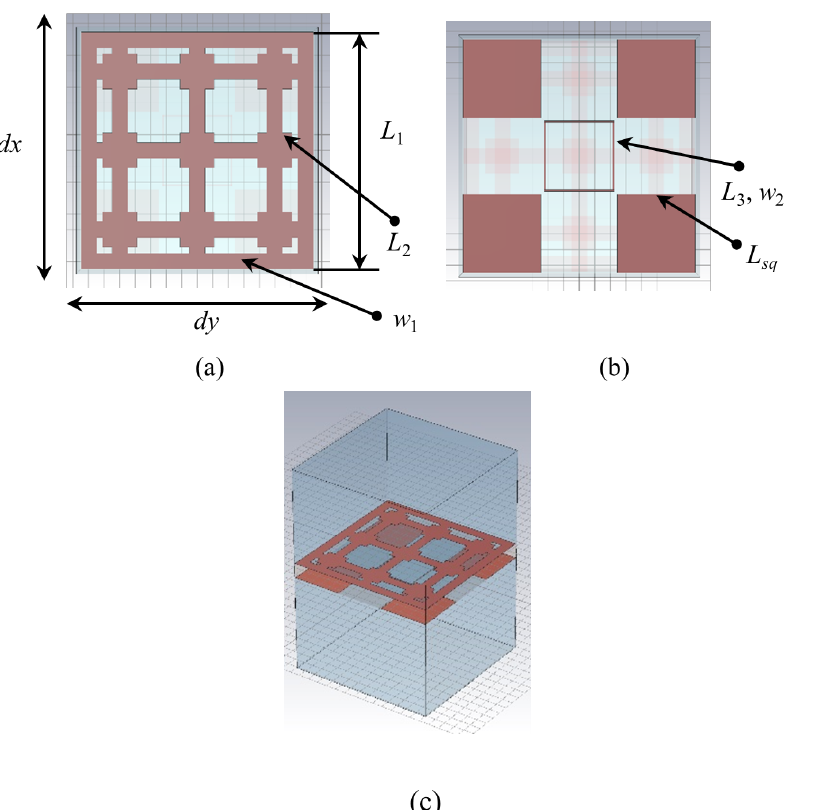
Figure 1. Unit cell geometry—CAD model: ( a ) Face 1; ( b ) Face 2; ( c ) rendering with removed substrate for better visibility.